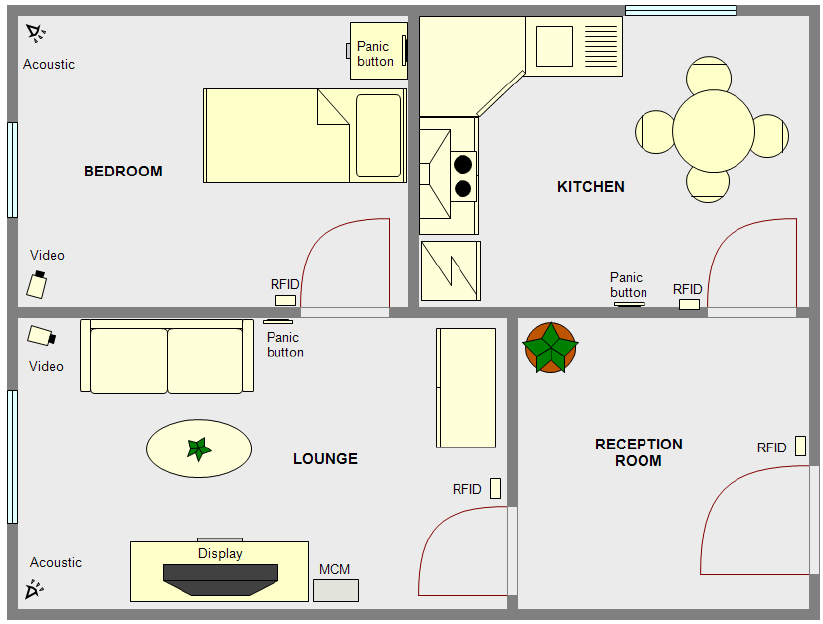
Figure 3. Example scenario of autonomous system at home case of